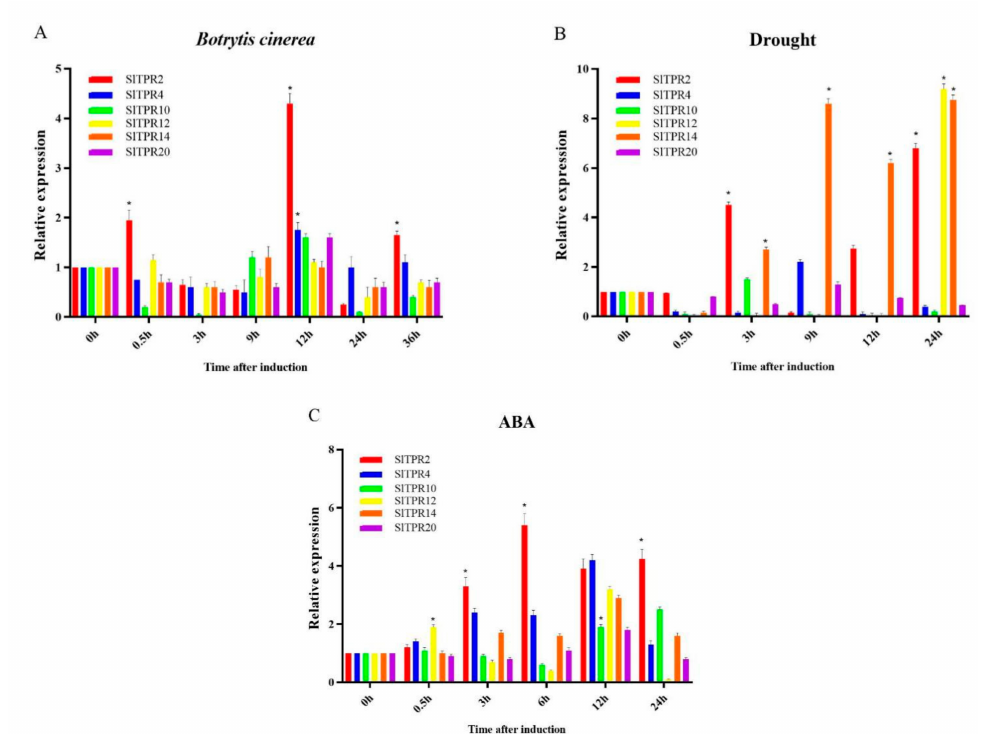
Figure 4. Expression analyses of tomato TPR genes under different stresses. Tomato seedlings were treated at 0 h with Botrytis cinerea ( A ), drought ( B ) and ABA ( C ) conditions and samples were collected for analysis at different times as indicated in the figure. The expression of each member of the tomato TPR gene family was detected by qRT-PCR. Columns are shown as the mean and the bars as the standard deviation of three biological and technical repeats. “*” represents a significant difference between the data point and control ( p <